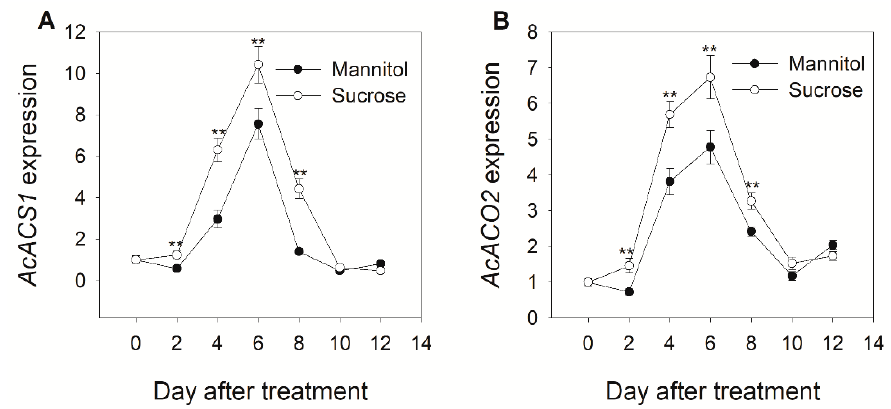
Figure 2. Changes in the expression of genes encoding enzymes involved in ethylene biosynthesis after sucrose and mannitol (control) treatment in kiwifruit during storage at 20 °C. ( A ) AcACS1 ; ( B ) AcACO2 . The data are expressed as the mean ± S.D. The asterisks indicate a significant difference relative to mannitol treatment according to the student’s t -test (** p < 0.01).